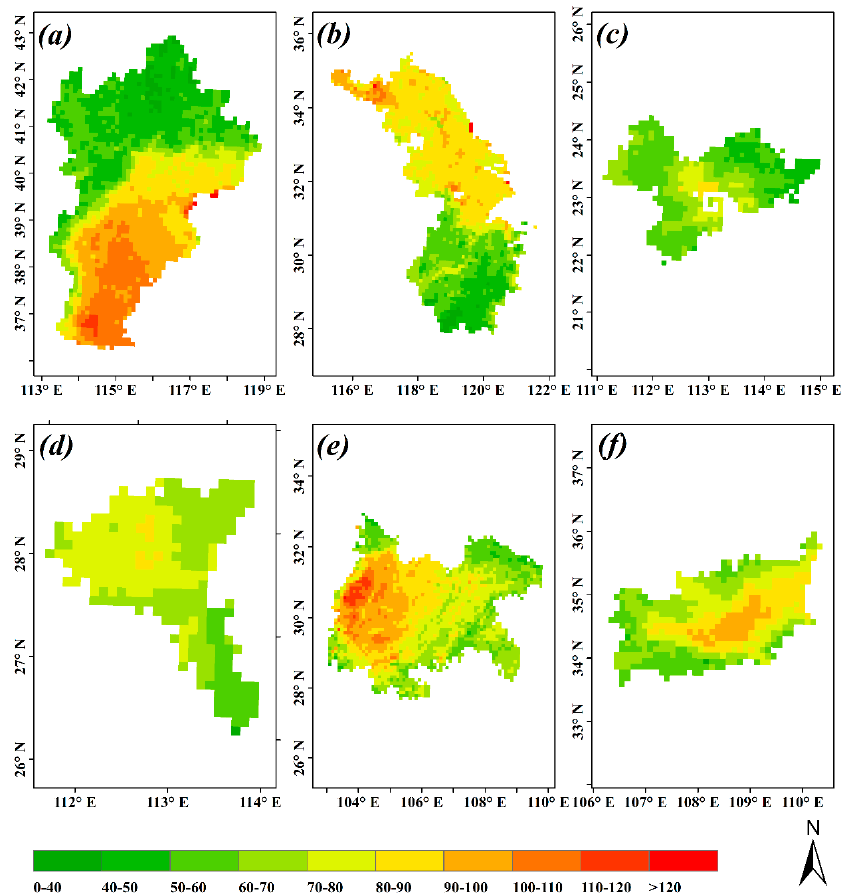
Figure 9. TSAM-based PM 2.5 concentration ( μ g/m 3 ) of ( a ) the Jing-Jin-Ji region; ( b ) the Yangtze River